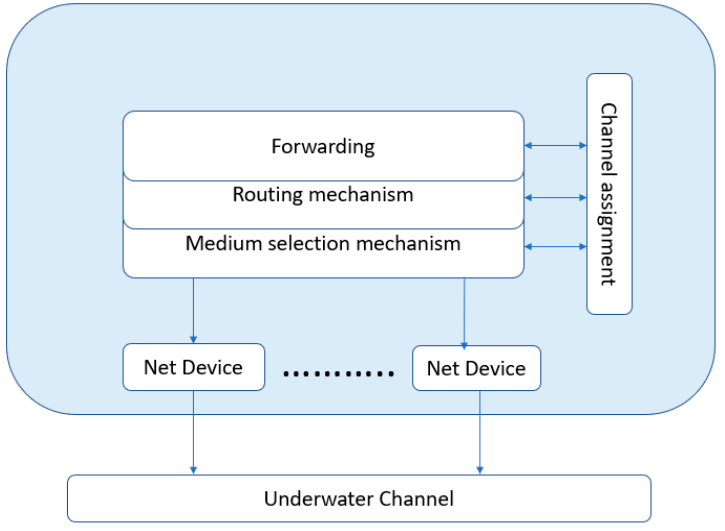
Figure 6 . Medium selection design scheme inside adaptation layer. Figure 6. Medium selection design scheme inside adaptation